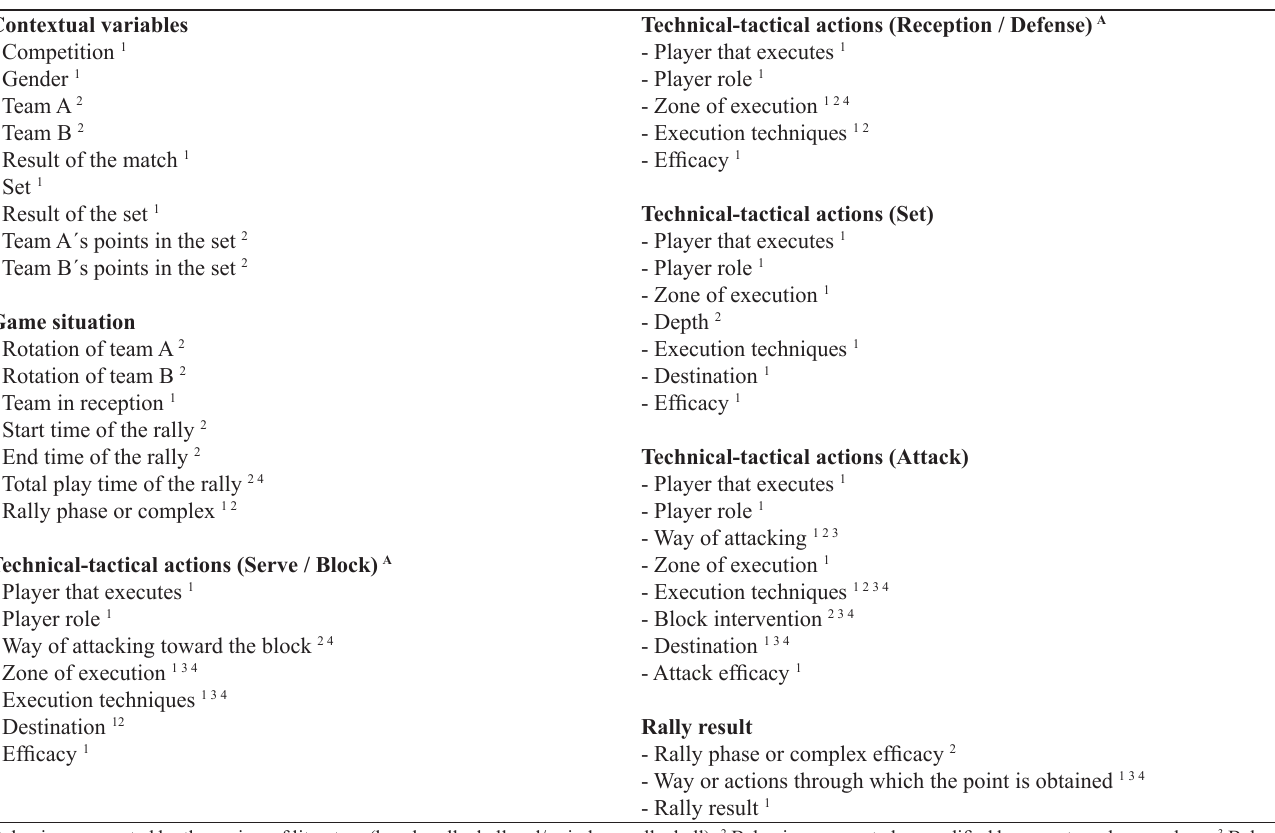
Table 2. Final behaviors of the first and second design stages of the observation